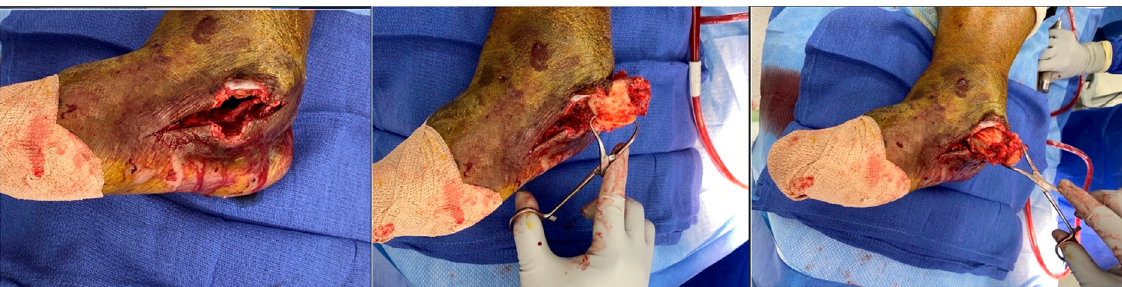
Figure 3. Talus extraction.